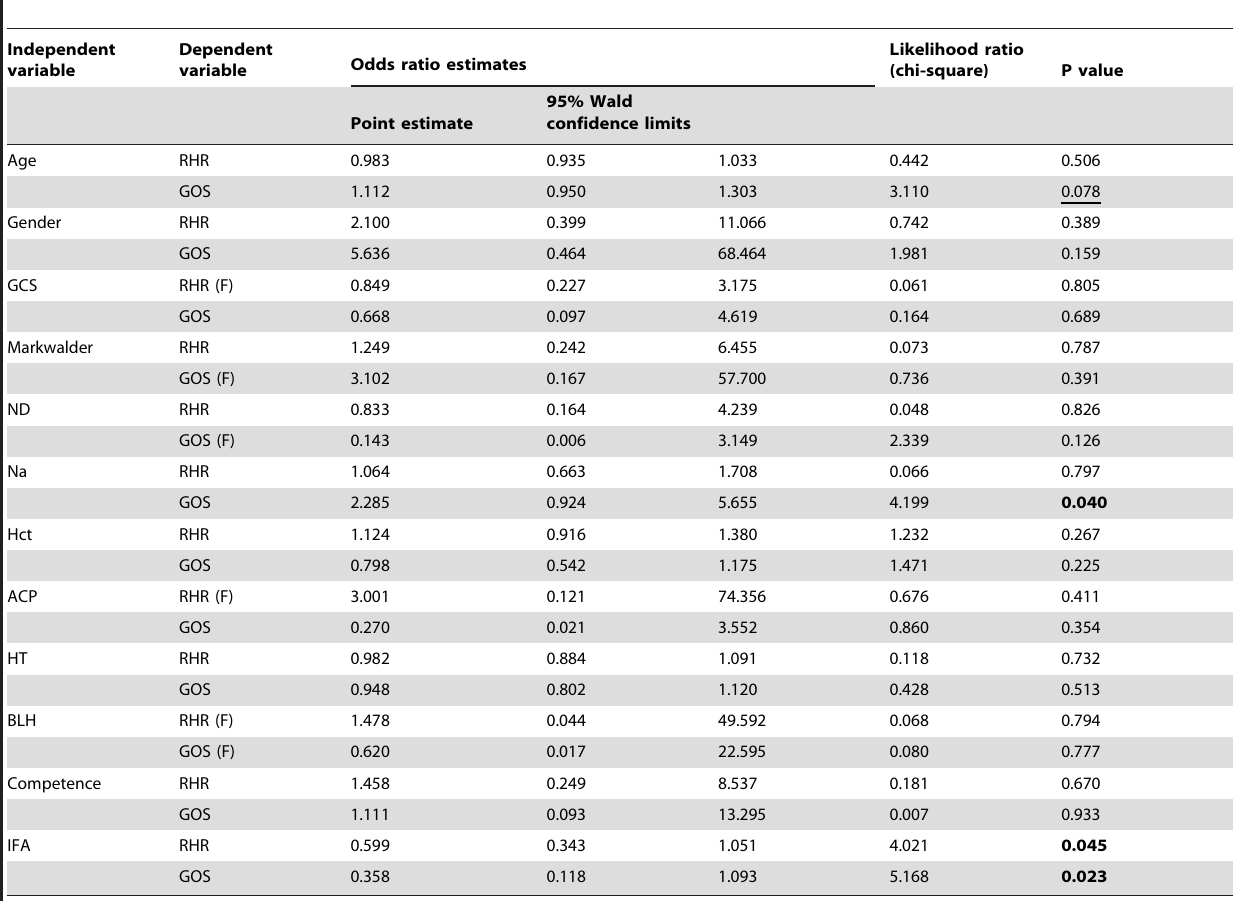
Table 2. Univariate regression